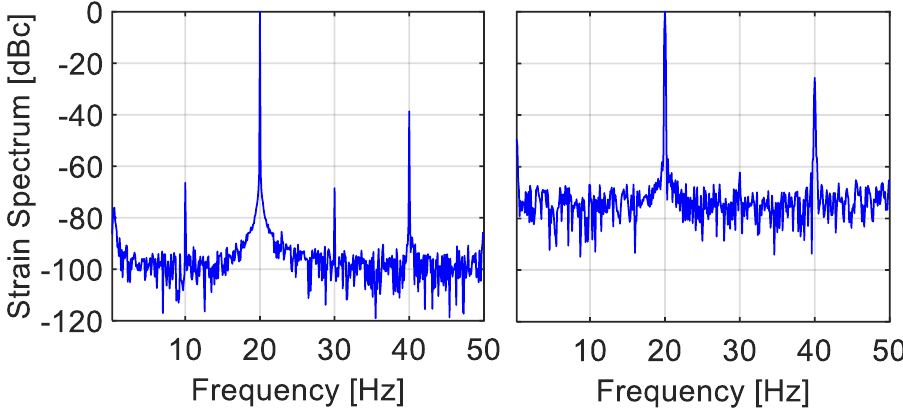
Figure 13. Hamming-weighed FFT spectra of the strain of the vibrating fiber in Figure 12, simulta- neously measured by the two interrogators. The scaled vibration frequency and amplitude were ξ = f signal / f scan = 0.2 and η = ν signal − amp / ν span scan = 0.38. ( Left ) Results from the uniformly triggered interrogator of Section 4. ( Right ) Results from the frequency-scanning CFG interrogator. While its noise level is higher, the peaks at 10 and 30 Hz are still barely seen (these < − 60 dB peaks are not folded harmonics, but are rather due to the insufficient spectral purity of the oscillator-shaker combination).